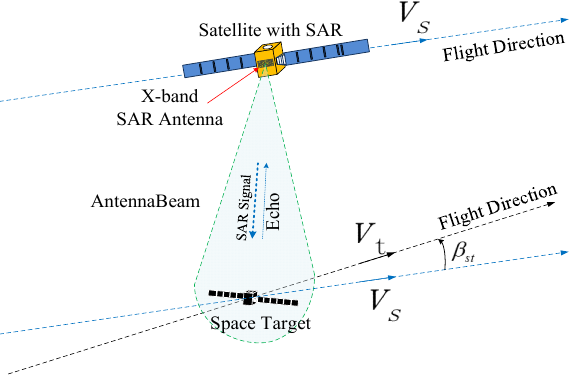
Figure 1. Imaging scene of space-borne SAR for space target.